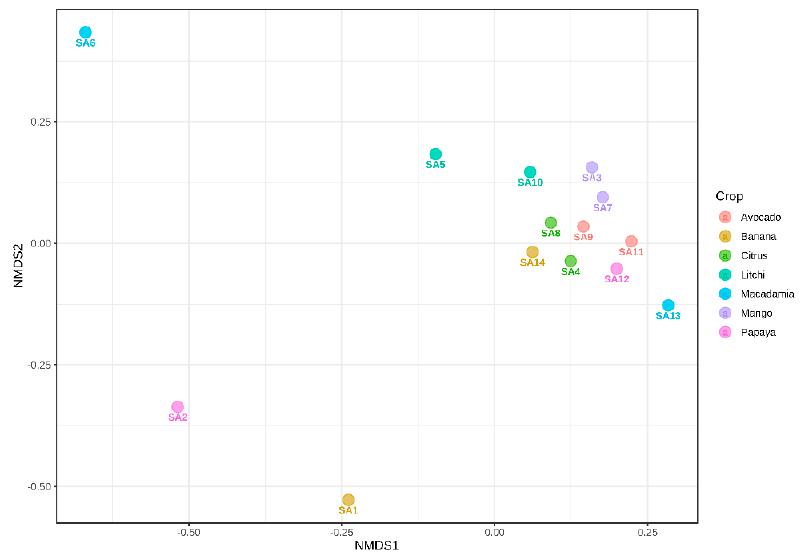
Figure 6. The NMDS diagram indicates the beta-diversity of bacterial communities among 14 subtropical fruit orchards from Mpumalanga province, South Africa. Permutational MANOVA (PREMANOVA) was used as the statistical method ( p ≤ 0.81), and the Bray–Curtis dissimilarity distance was used to determine differences and similarities among the samples.